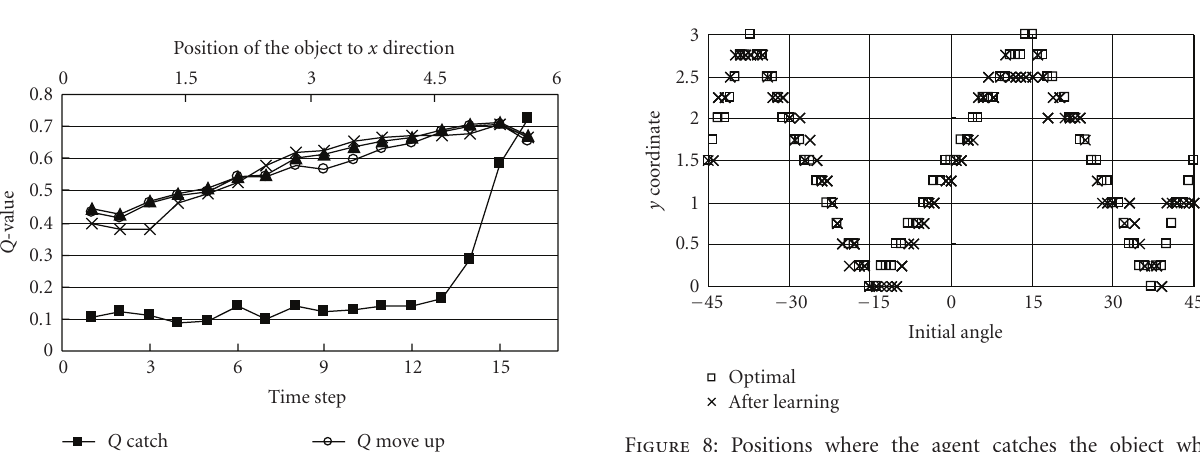
Figure 8: Positions where the agent catches the object when the initial object direction of motion varies (with the maximum invisibility